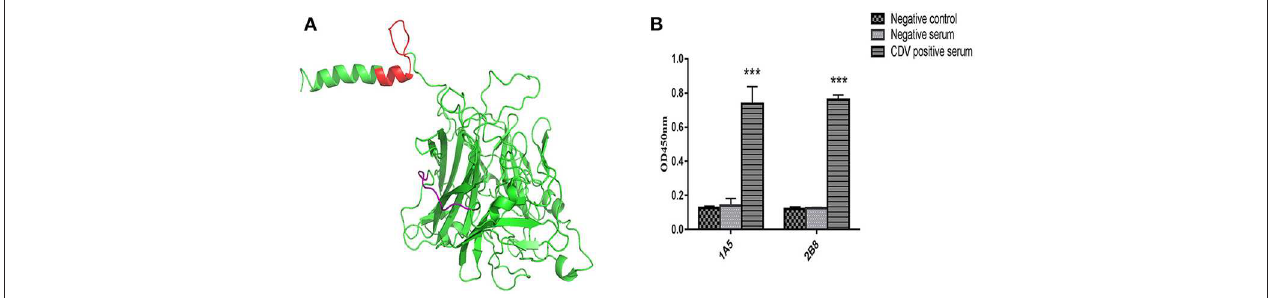
FIGURE 4 | (A) Structural location analysis of epitopes on the CDV H protein (obtained from the Protein Data Bank). Location analysis of the identified B-cell epitopes using PyMOL software. The epitope 178 ARGDIFPPY 186 is labeled and shown in purple, and the 120 QKTNFFNPNREFDFR 134 location is shown in red. (B) Serological test for CDV H protein and the identified epitopes. The 178 ARGDIFPPY 186 epitope specific antibody and the 120 QKTNFFNPNREFDFR 134 epitope in anti-CDV sera were detected by peptide-coated indirect ELISA ( n = 3). Asterisk indicates significant differences between CDV-positive sera and CDV-negative sera, or between controls (* P < 0.05; ** P < 0.01; *** P <